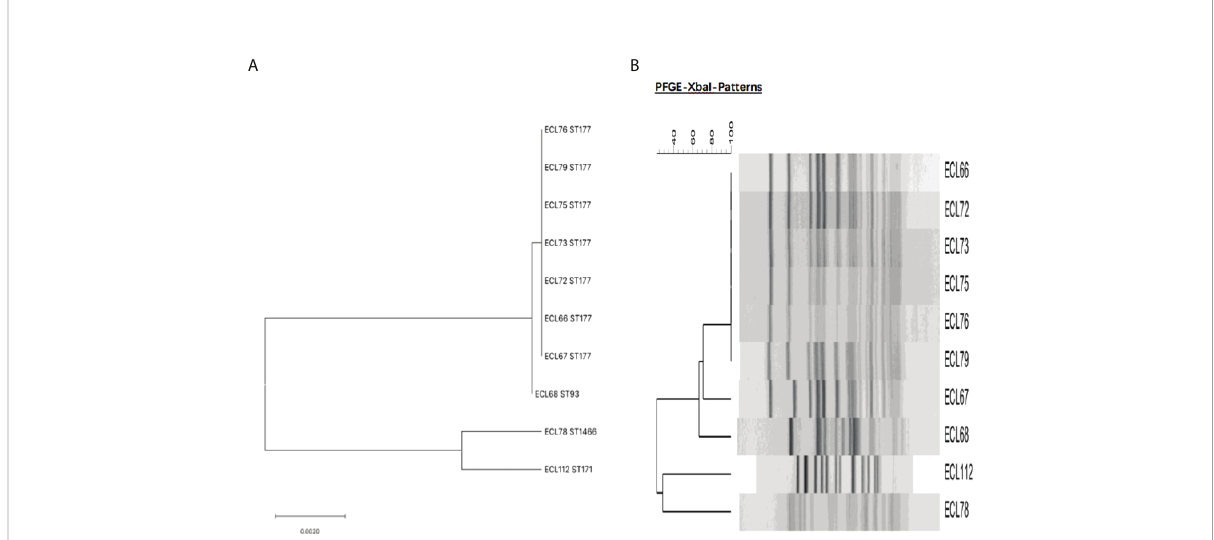
FIGURE 1 (A) Molecular phylogenetic analysis by MLST of NDM-1-producing CREL isolates. (B) Dendrogram of the PFGE pro fi les of NDM-1-producing CREL